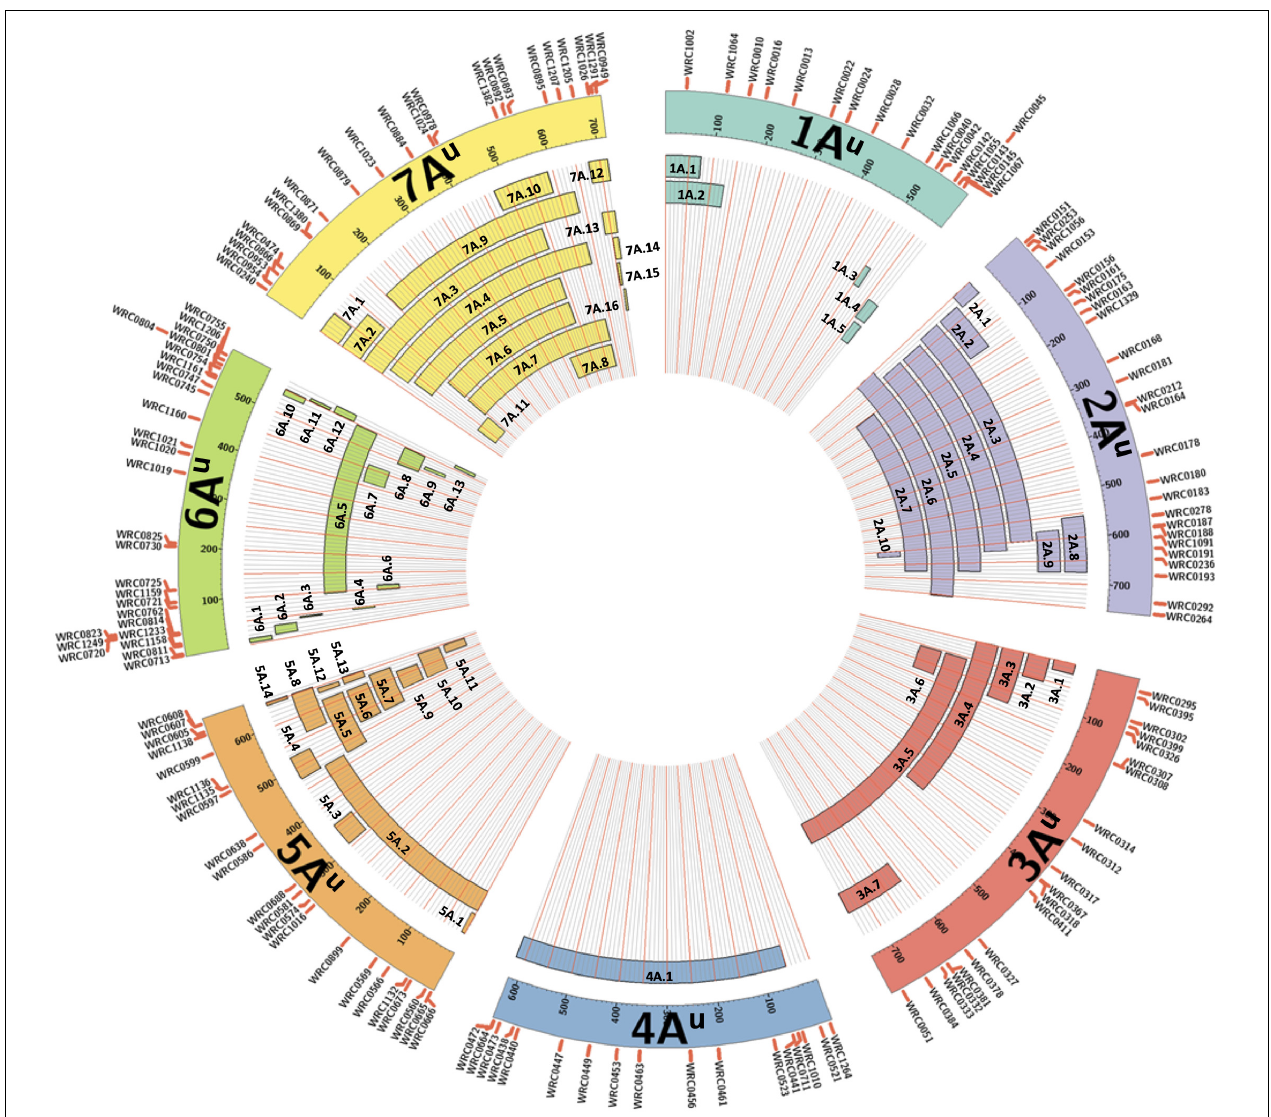
FIGURE 1 | A graphical representation of the sizes of the 65 unique introgressions of T. urartu , along each T. urartu chromosome, found in the DH lines. In each of the seven chromosomes, the KASP markers are shown ordered according to their physical position (Ling et al., 2018). Each segment is given a unique name which is used to characterise the DH lines in Table 2